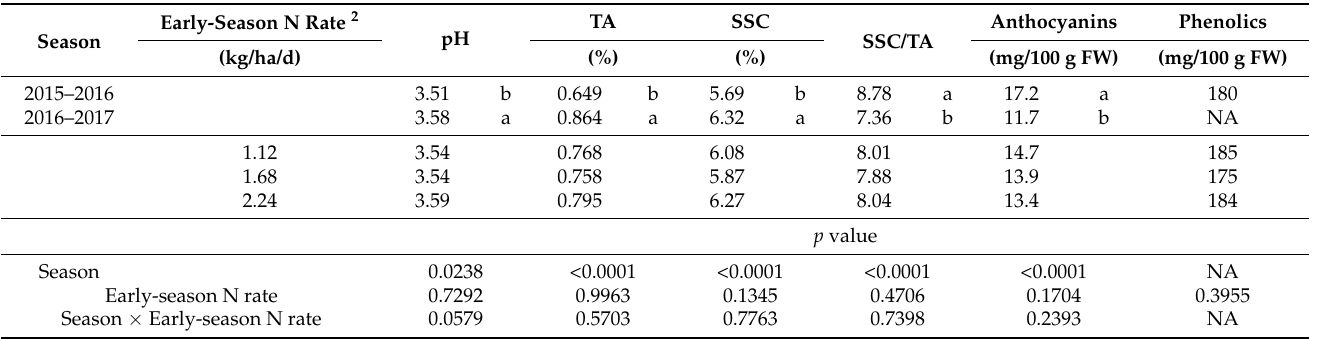
Table 4. Chemical characteristics of ‘Florida Radiance’ strawberry as affected by season and early-season nitrogen (N) fertilization rate 1